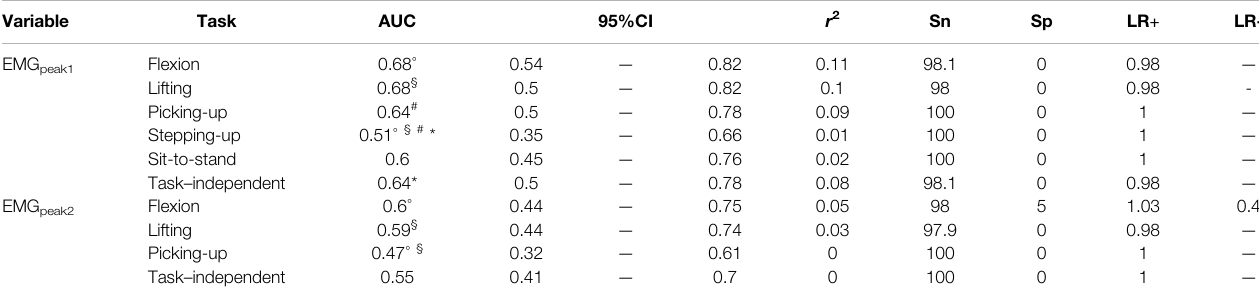
TABLE 4 | Logistic regression models for lumbar muscle activity measures. AUC: area under the curve [with its con fi dence interval (95%CI)]; r 2 : coef fi cient of determination; Sn: sensitivity; Sp: speci fi city; LR+: positive likelihood ratio; LR − : negative likelihood ratio. Symbols ( ° , §, #, *) indicate a difference of AUC > 0.1 between two tasks or between a speci fi c-task and the task – independent measure.